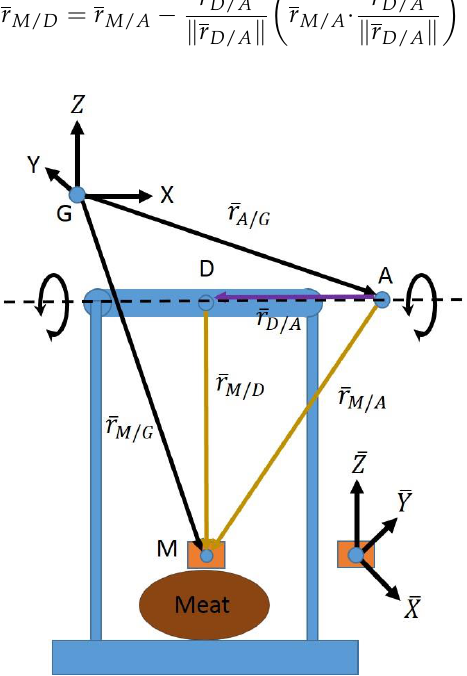
Figure 7. The pendulum apparatus with the meat (oval) and the corresponding sensor (block on top of oval). The three vectors at point G represent the axes of the global coordinate system. The bars on top of the vectors denote that they are expressed in the local coordinate system defined by the markers attached to the meat-mounted IMU (defined per Figure 6). The axes of the local coordinate system are shown at right, and the origin of the local coordinate system coincides with point M. Point A represents the point along the joint axis determined by the optimization process for the corresponding frame. Finally, point D represents the to-be-calculated point along the joint axis to which point A will be projected. The resulting location of point D acts as the instantaneous joint center for the corresponding data frame.